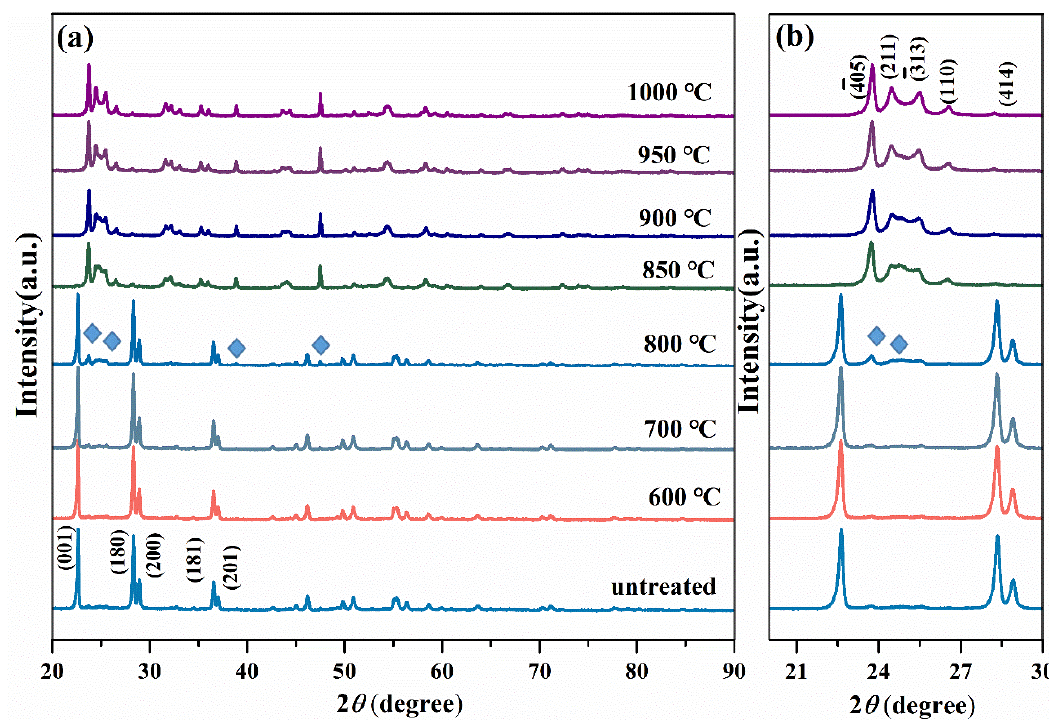
Figure 1. XRD patterns of Nb 2 O 5 precursor powders treated at different temperatures, in the following ranges: ( a ) 20 °< θ < 90°; ( b ) 20°< θ <30°.The blue square indicates the presence of monoclinic Nb 2 O 5 .